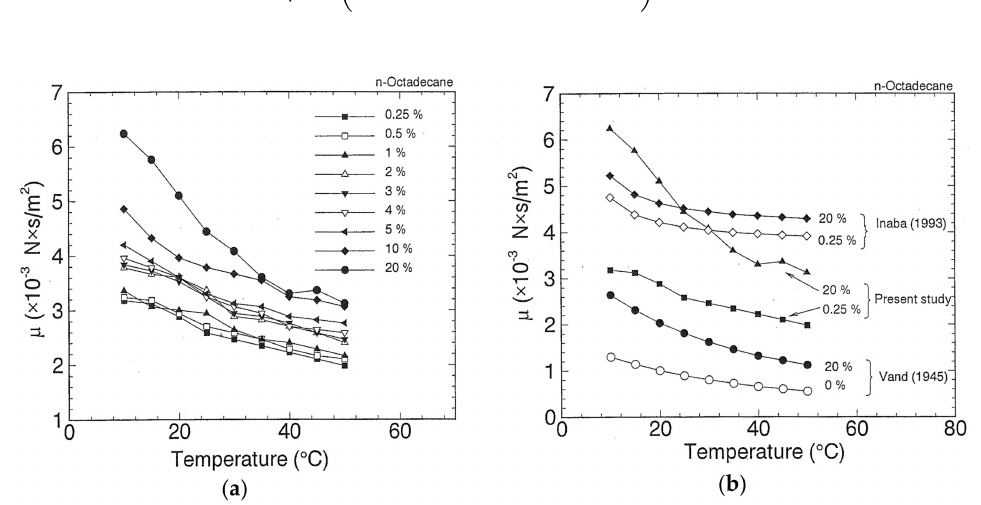
Figure 3. ( a , b ) Relationship between the viscosity and temperature of the suspension fluid.